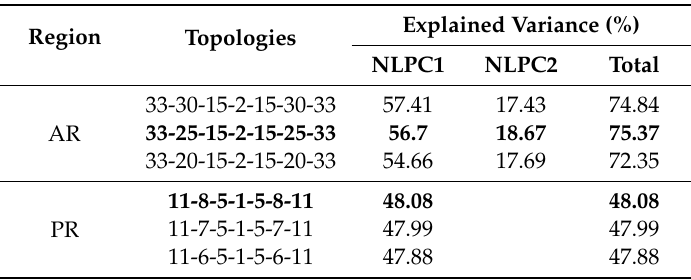
Figure 6a indicates the time series of the first NLPC for AR (NLPC1-AR). Positive (negative)